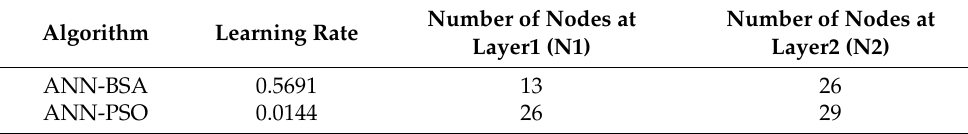
Table 3. ANN setup parameters for ANN-BBSA and ANN-BPSO